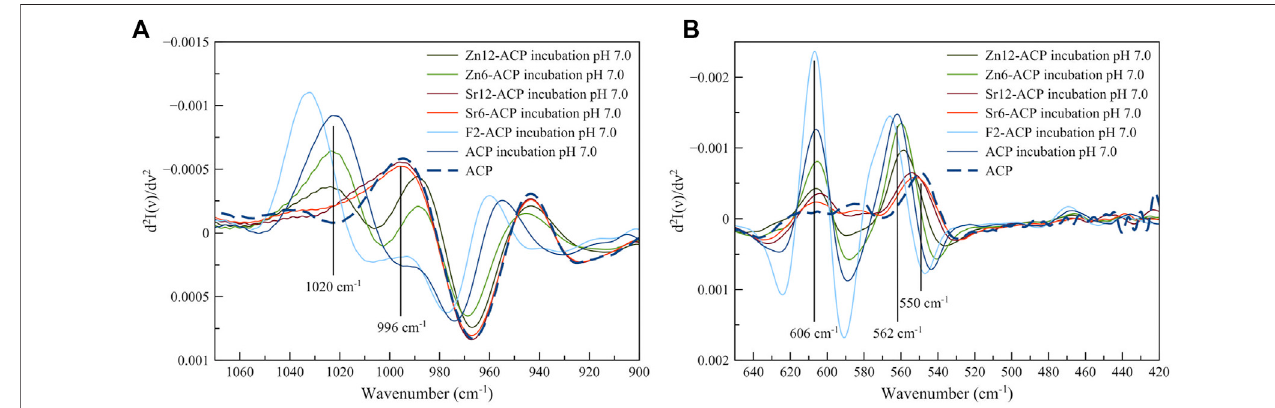
FIGURE5| SecondderivativeofFT-IRspectraofACPandACPsmaterialsafterincubationfor24 hat37 ° CatpH7.0.SamplesincubatedatpH4.5havethesame pro fi le. (A) is focused on ν 3 PO 4 peak region and (B) is focused on the ν 4 PO 4 peak